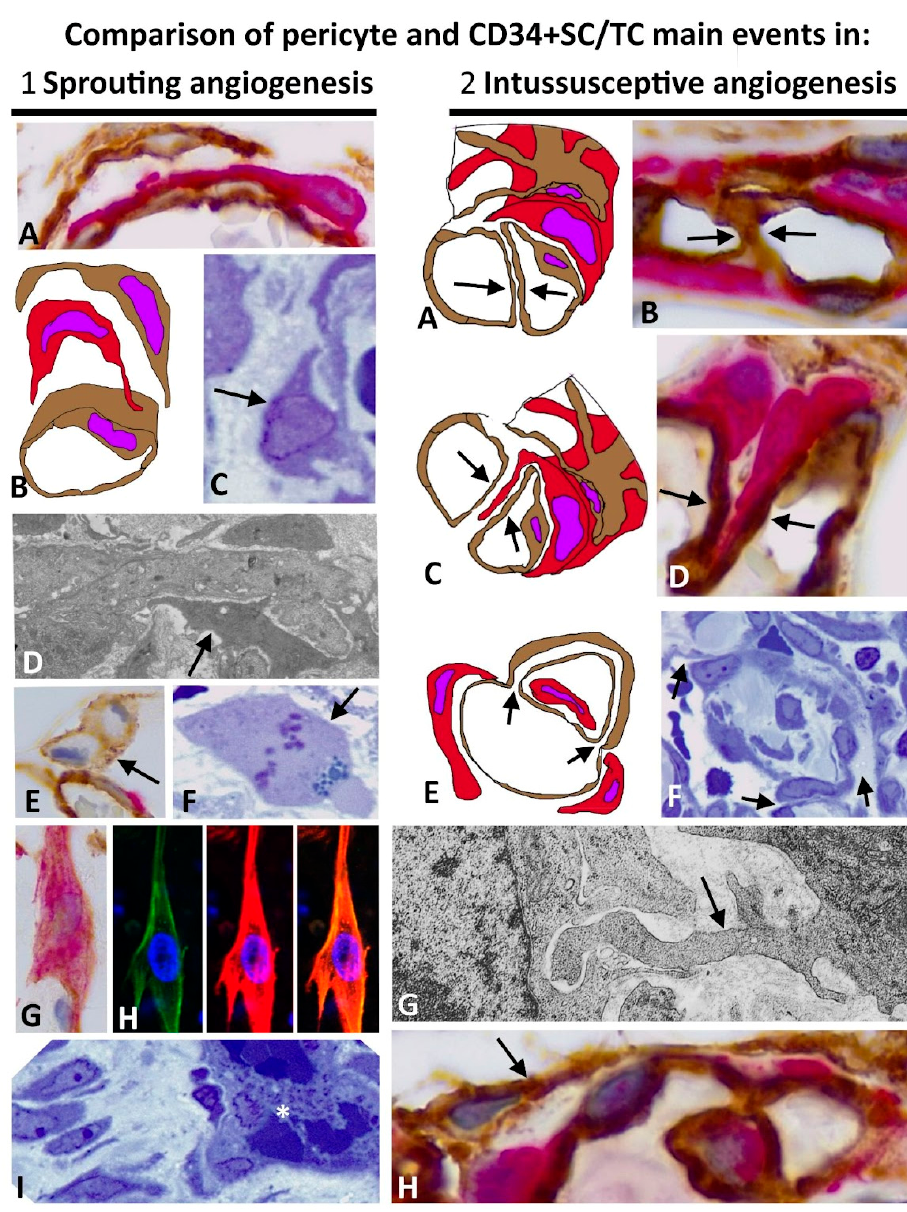
Figure 12. Schematic and microphotographic representation of the main aspects of the behavior of pericytes and CD34+SCs/TCs in sprouting (1) and intussusceptive (2) angiogenesis. (1) In sprouting angiogenesis, pericytes and CD34+SCs/TCs of the activated pre-existing vessels ( A ) detach from the vessel wall ( B , C , arrow). Pericytes proliferate and are recruited in the endothelial sprouts ( D , arrow), leading to EC survival, basal membrane deposition, and vessel stabilization. CD34+SCs/TCs prolif- erate ( E , arrow), some acquire lipofibroblast-like characteristics ( F , arrow) and show coexpression of CD34 and α SMA ( G , H ), transforming into α SMA+ myofibroblasts. Many newly formed vessels regress, showing intraluminal aggregate of platelets (asterisk) with increased interstitial myofibrob- lasts ( I ). (2) In intussusceptive angiogenesis, pericytes, and less frequently CD34+SCs/TCs may form part of the intravascular pillar cores. Incorporation depends on the mechanism of pillar development, for example, by extension after endothelial bridge formation ( A – D , arrows) or by engulfment through vessel loop formation ( E , F , arrows). Numerous peg-and-socket junctions are established between pericytes and ECs ( G , arrow). Generally, perivascular and interstitial CD34+SCs/TCs remain with scarce modifications ( H , arrow). Bar: sprouting ( A , G , H ): 8 µ m; ( C ): 12 µ m; ( D ): 0.8 mm; ( E ): 30 µ m; ( F ): 15 µ m; ( I ): 10 µ m. intussusceptive (2): ( B , D ): 30 µ m; ( F ): 45 µ m; ( G ): 2 µ m; ( H ): 15 µ